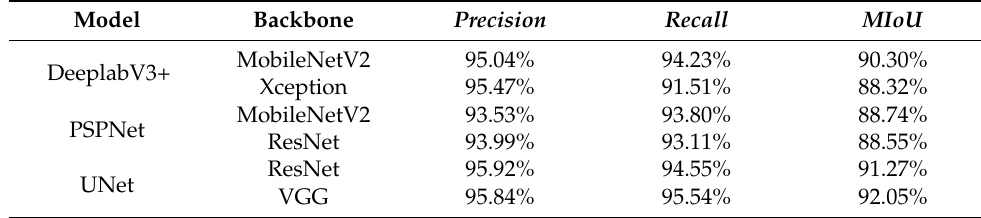
Table 3. Performance comparison of models in disease